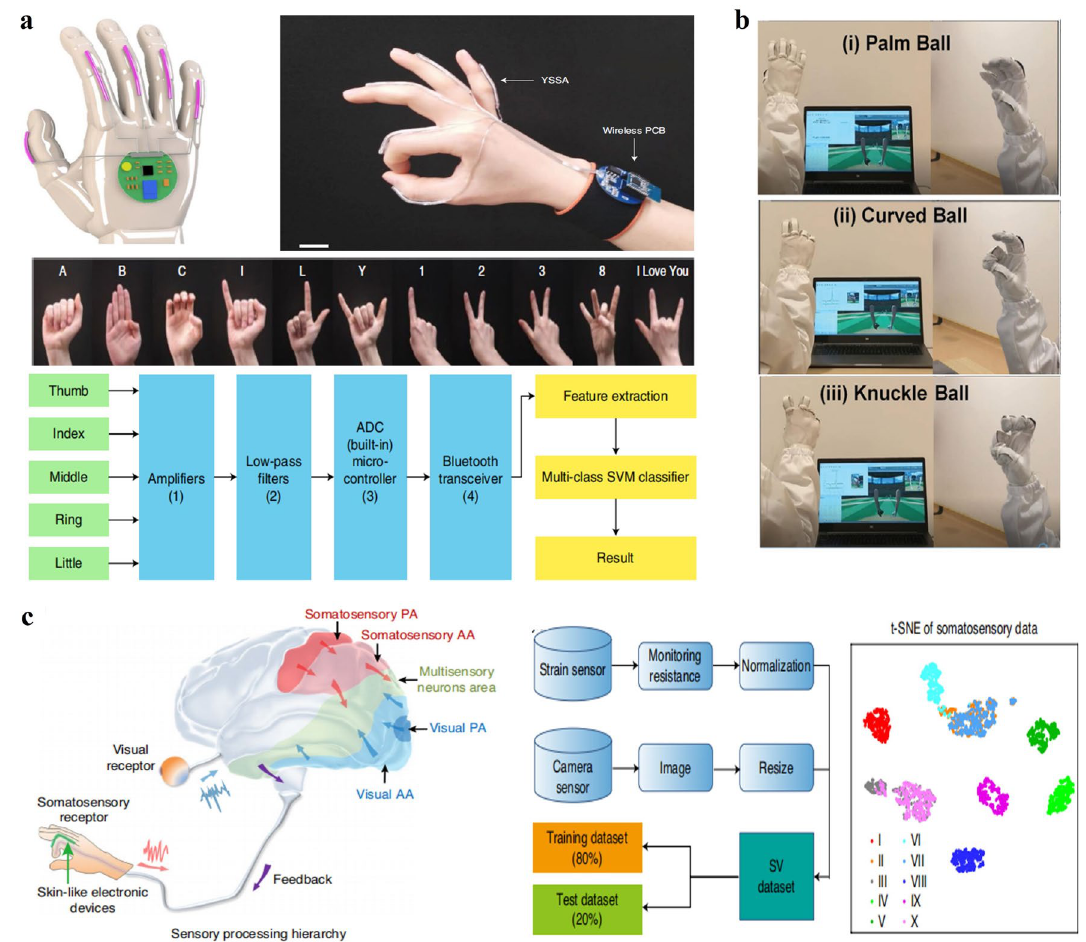
Fig. 11 a HMI applications of sign language translation enabled by a stretchable strain sensor array on fingers and ML techniques [23]. Copy- right (2020) Springer Nature. b HMI applications of VR control enabled by smart gloves and ML techniques [175]. Copyright (2020) The Authors. c HMI applications of hand gesture recognition enabled by analyzing visual data and somatosensory data from stretchable strain sen- sors on fingers via ML techniques [114]. Copyright (2020) Springer